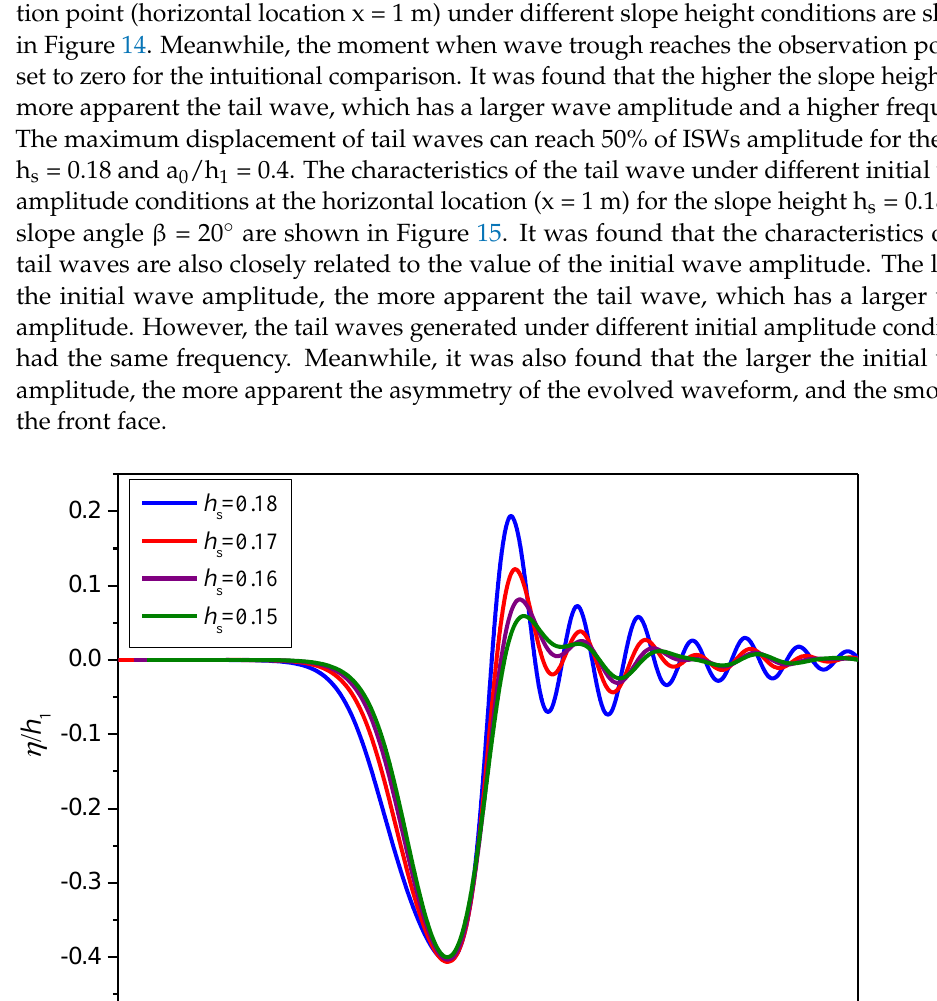
t Figure 15. Characteristics of the tail waves for different initial wave amplitudes. 4. Conclusions In this study, we developed a numerical model to calculate the propagation and evolution of internal solitary waves on slope topography, and a series of calculations were performed for different slope geometrical parameters, initial amplitudes, and den- sities jump of two-layer fluid. The influence of different slope heights and slope angles on the evolution characteristics of internal solitary waves was discussed, and the fol- lowing conclusions were obtained.